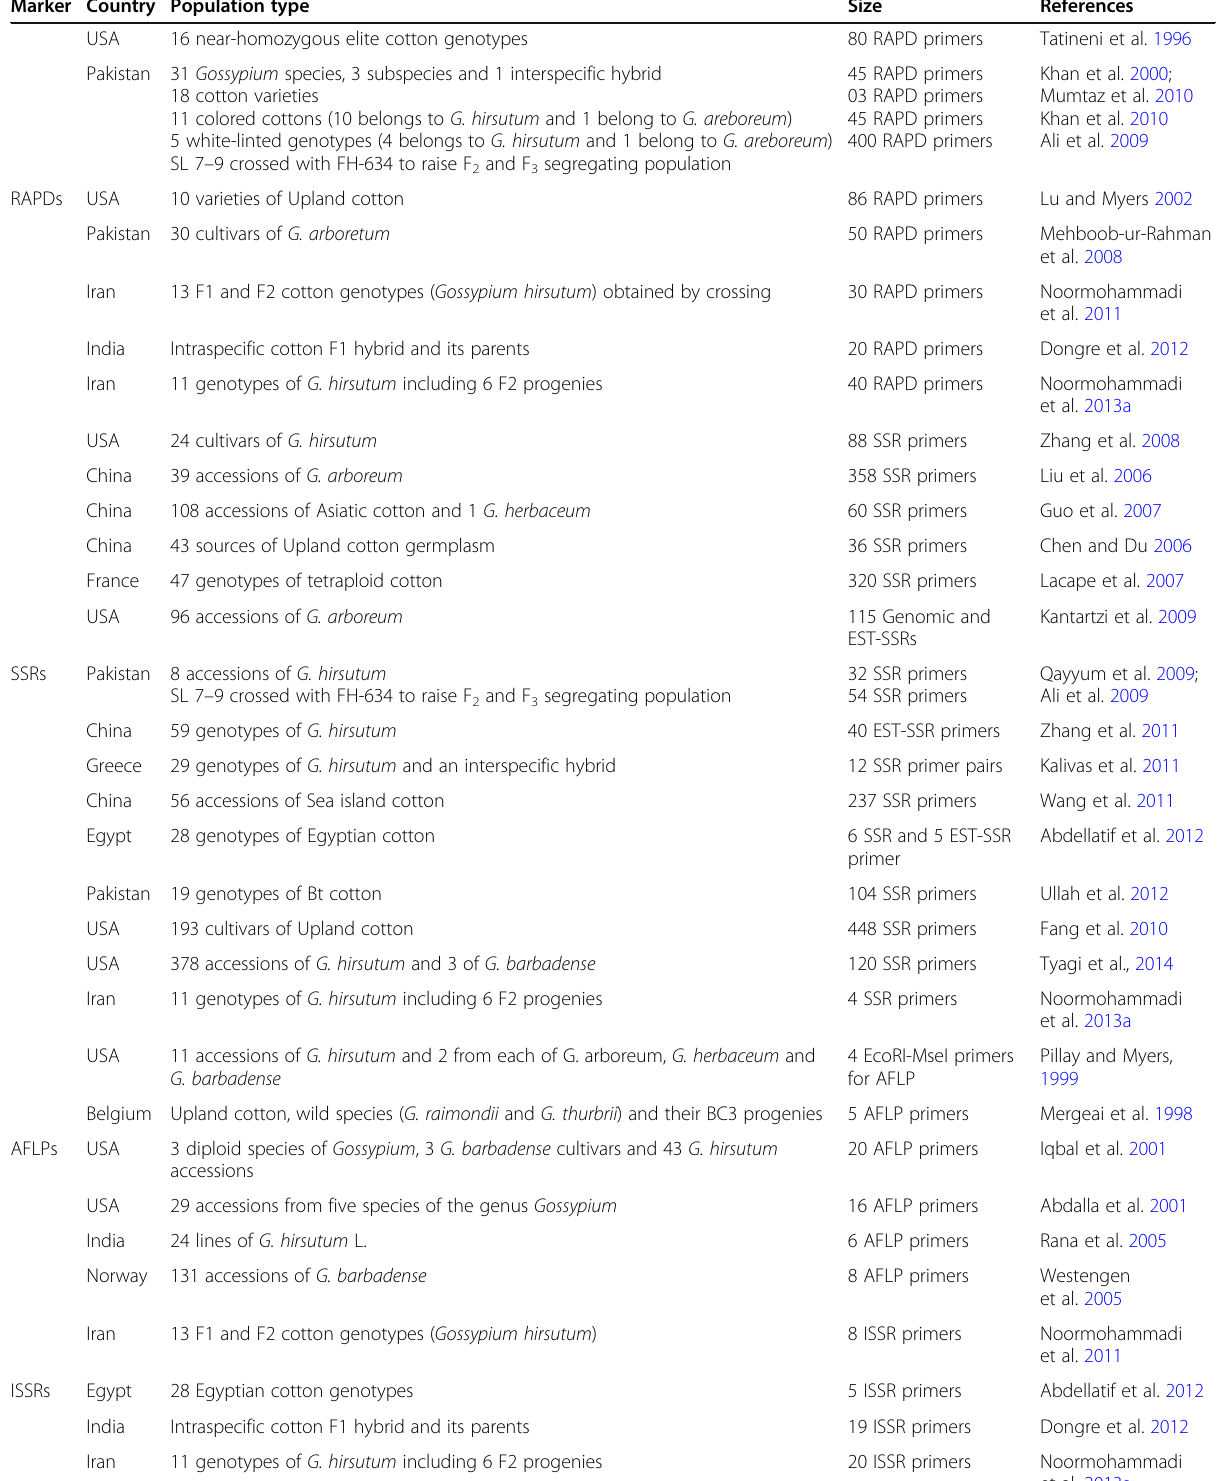
Table 4 An overview of genetic diversity studies in cotton using molecular markers Marker Country Population